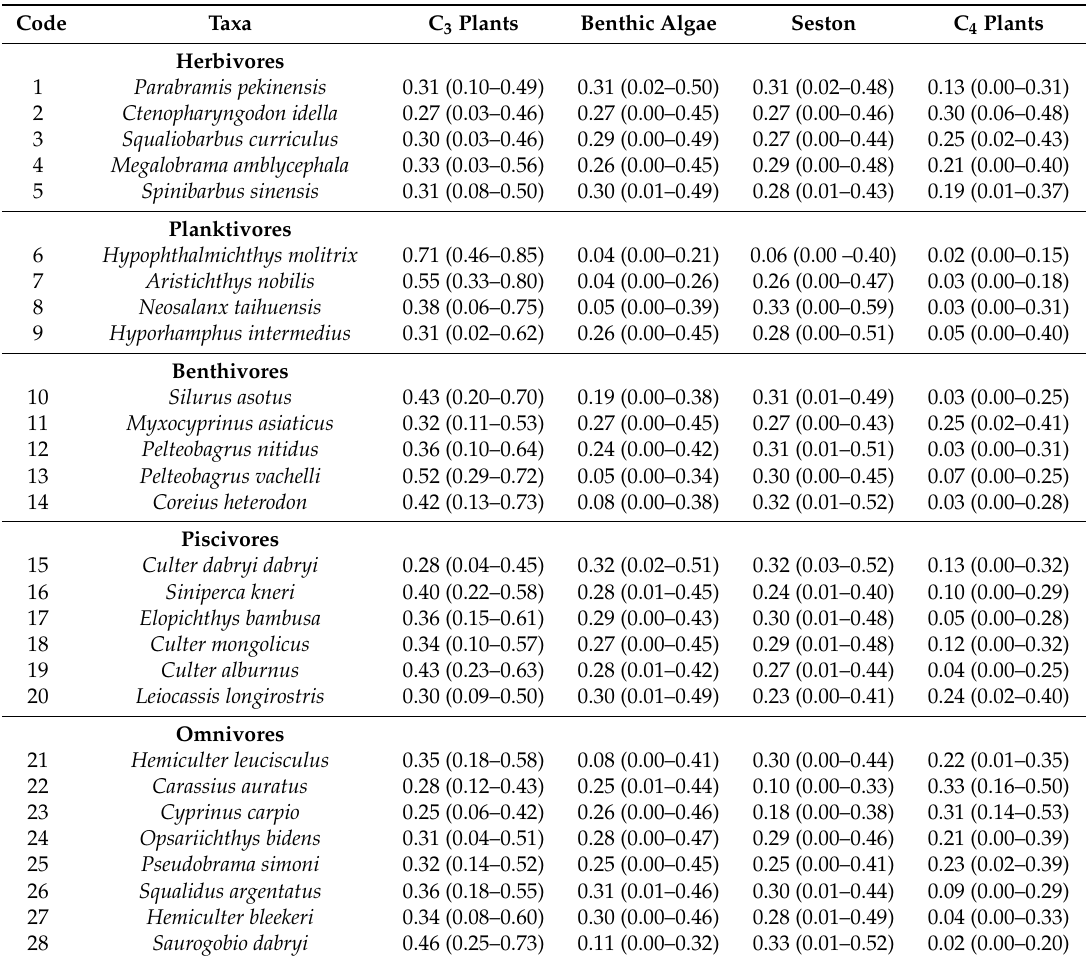
Table 1. Bayesian isotopic mixing model estimates of the highest likely percent contributions (95% BCI, Bayesian credibility interval) of basal carbon sources to different feeding types of fish species collected from the downstream (backwater zone) of the Daning River.